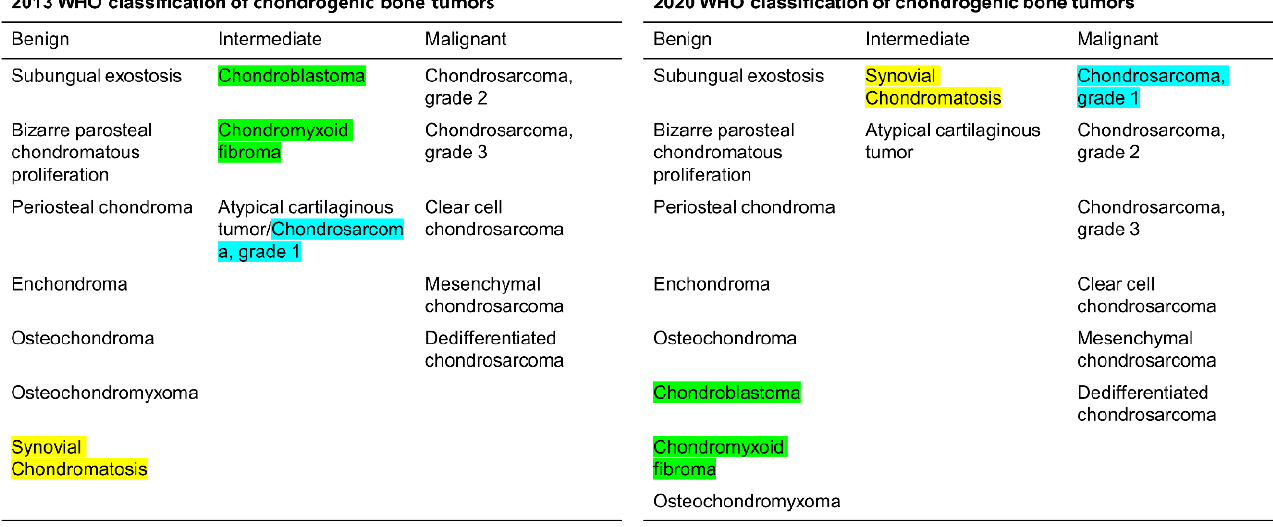
Figure 1. Comparison of the 2013 and 2020 World Health Organization (WHO) classifications of chondrogenic bone tumor. Diseases highlighted are those that are subject to change from 2013 to 2020 WHO classification.